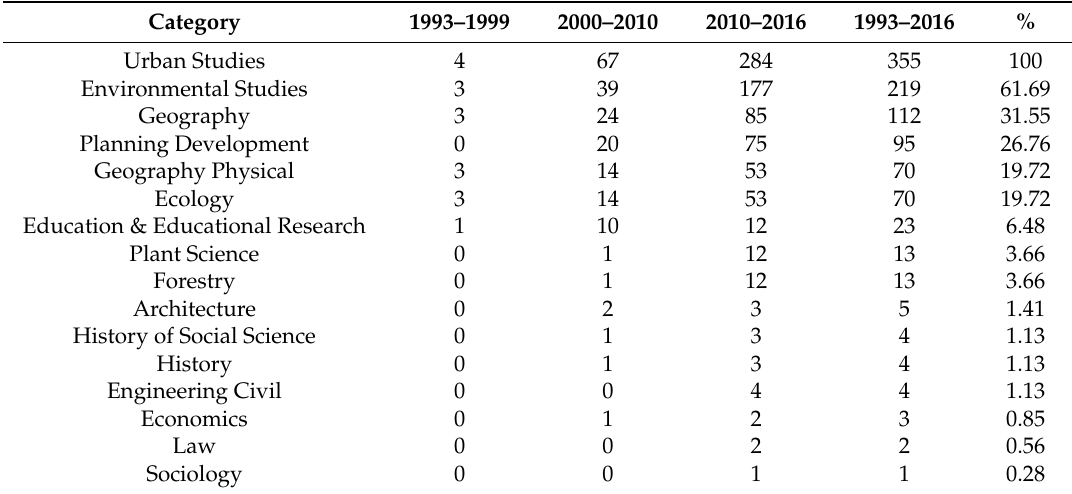
Table 2. The subject categories of 355 publications on urban resilience